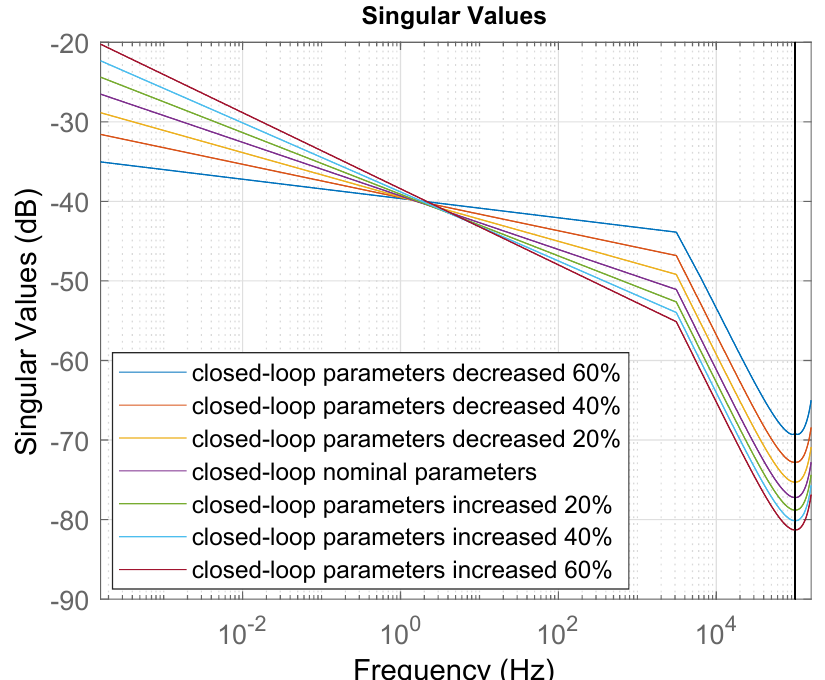
Figure 3. Singular values for closed loop changing the